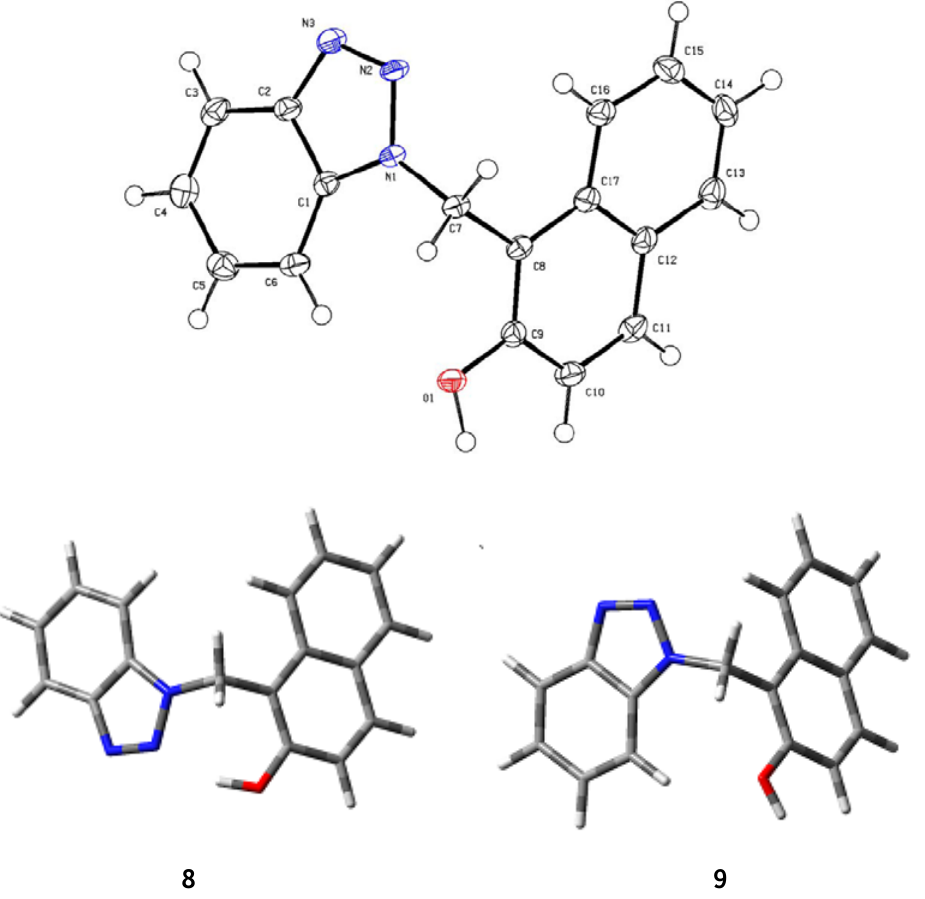
Figure 1. Molecular structure of 6 at 100 K. Thermal ellipsoids are shown at 50%